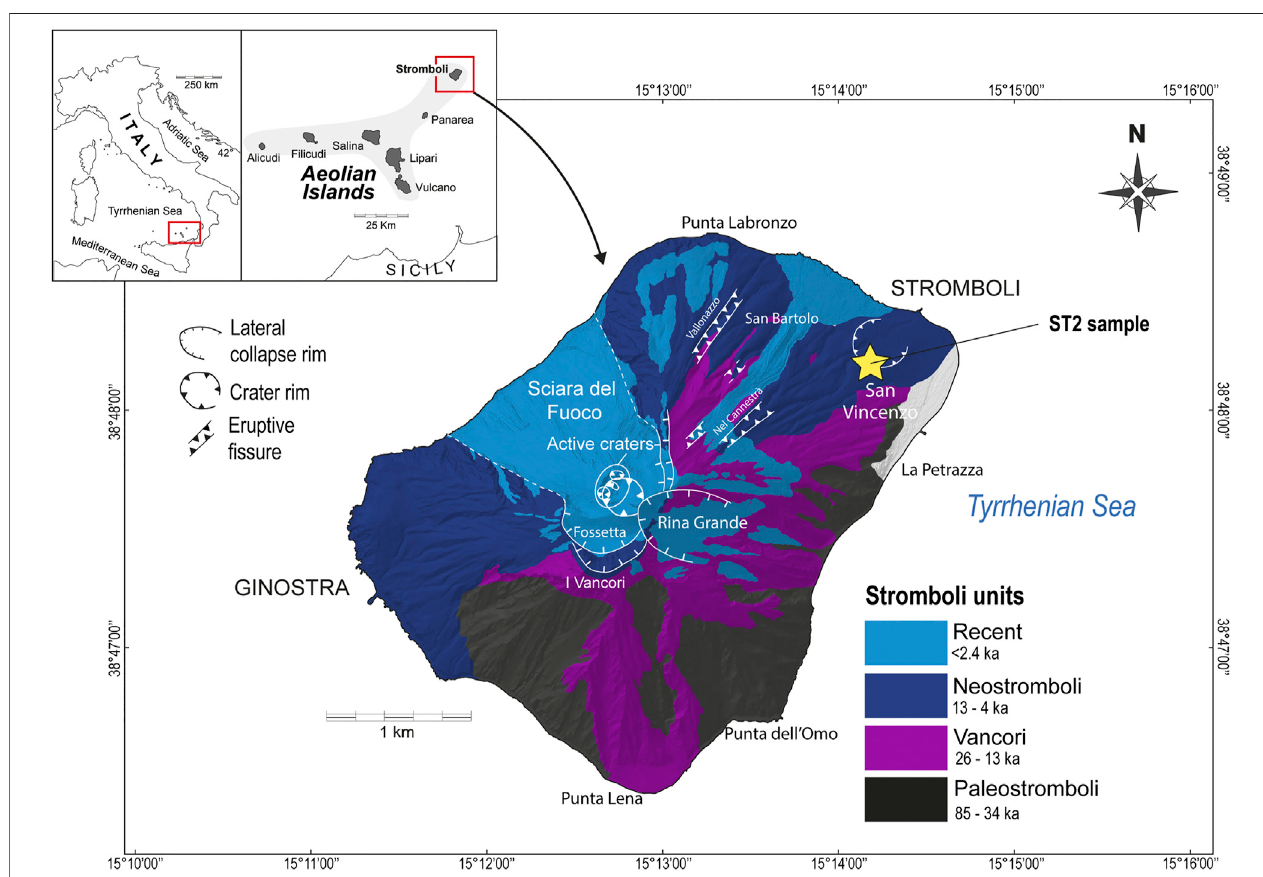
FIGURE 1 | Map of Stromboli. The different lava units are shown in different colors (modi fi ed after Francalanci et al., 2013). The yellow star represents the site of sample ST2, used for this study.